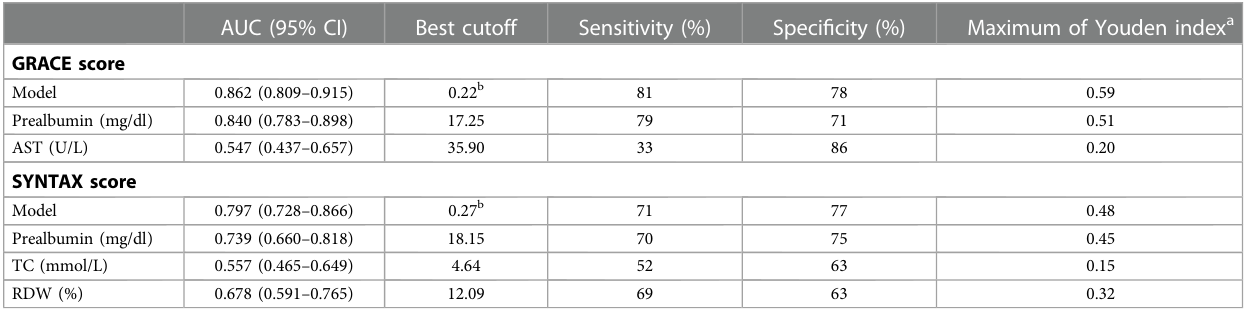
TABLE 5 Receiver operator characteristic analyses of important indexes and model in ACS patients.